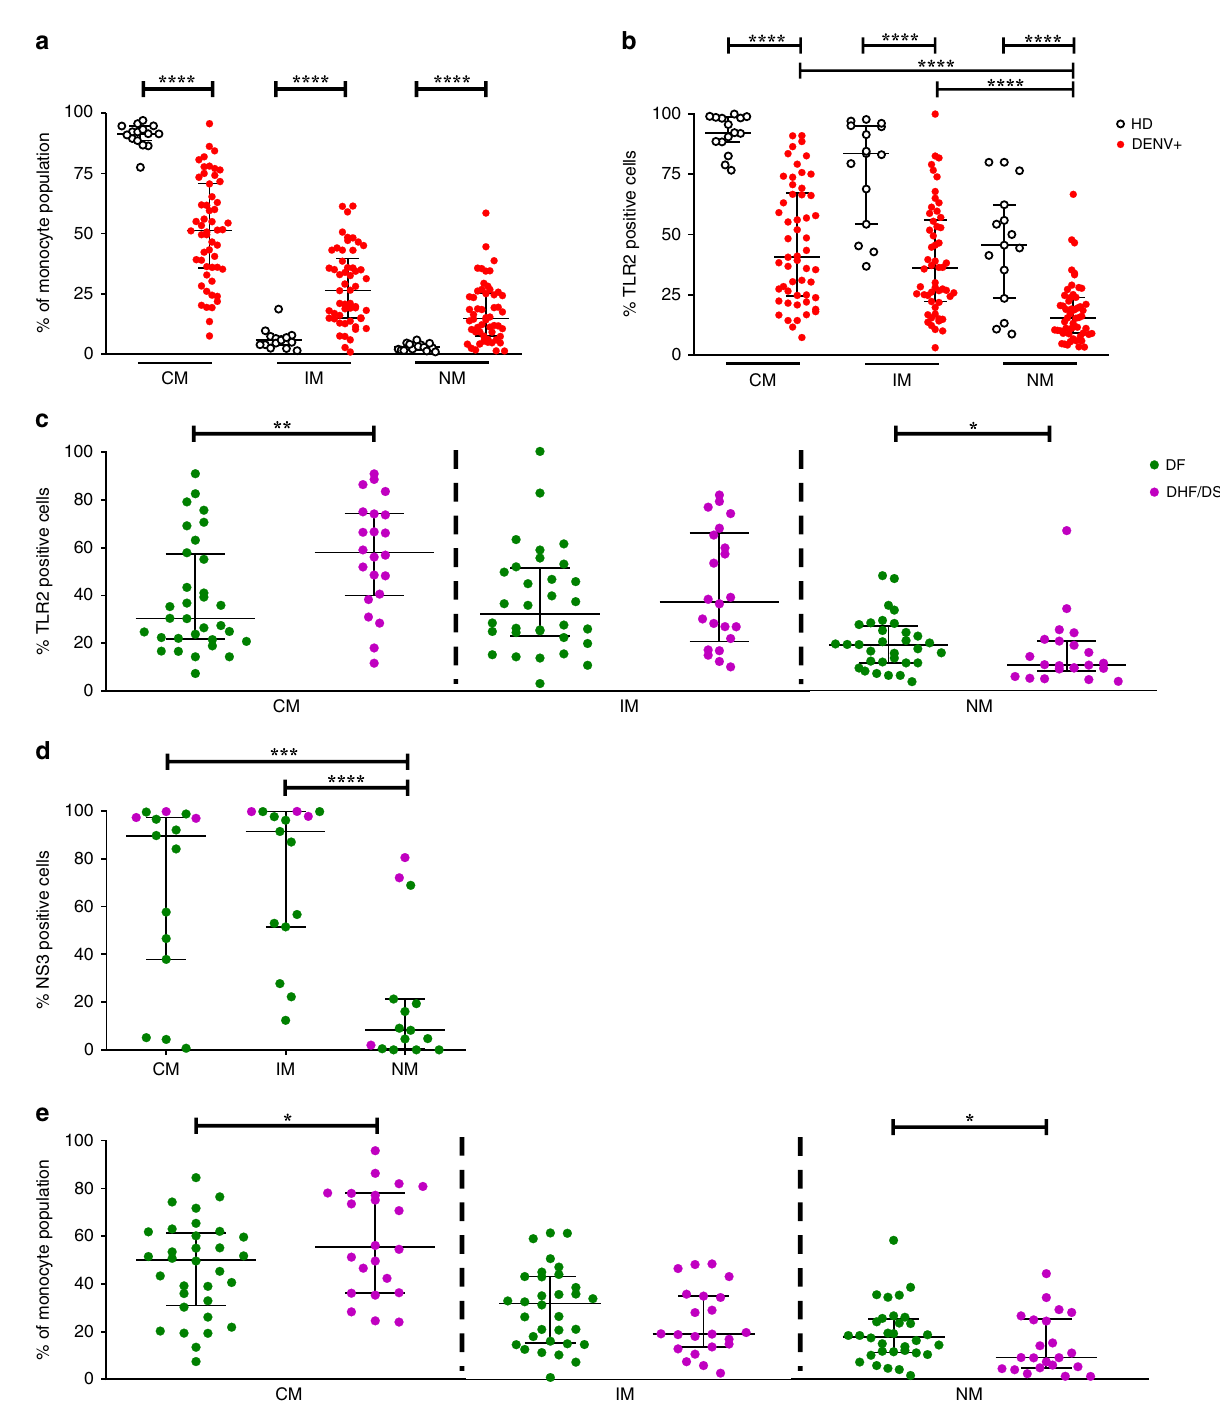
Fig. 1 Sustained high expression of TLR2 and increased frequency of monocytes correlates with DENV disease severity. a – e PBMCs were isolated from 15 age-matched healthy donors (HD) and 54 patients undergoing acute DENV infection (DENV + ) who developed relatively mild (DF, n = 32) or severe (DHF/DSS, n = 22) disease. a Monocyte subsets distribution in healthy and DENV + patients (two-tailed Mann – Whitney test, **** P < 0.0001). b Percentages of cells expressing TLR2 were determined for each monocyte subset (two-tailed Mann – Whitney test, **** P < 0.0001) and c strati fi ed by disease severity (two-tailed Mann – Whitney test, * P < 0.05; ** P < 0.01). d Percentages of NS3 + infected cells in DENV-positive patients ( n = 15) stained intracellularly for DENV NS3 (two-tailed Mann – Whitney test, *** P < 0.001; **** P < 0.0001). e Monocyte subsets distribution in patients, strati fi ed by disease severity (two-tailed Mann – Whitney test, * P < 0.05). CM classical monocytes, IM intermediate monocytes, NM non-classical monocytes. Bars represent median with interquartile range (IQR). Source data are provided as a Source data fi